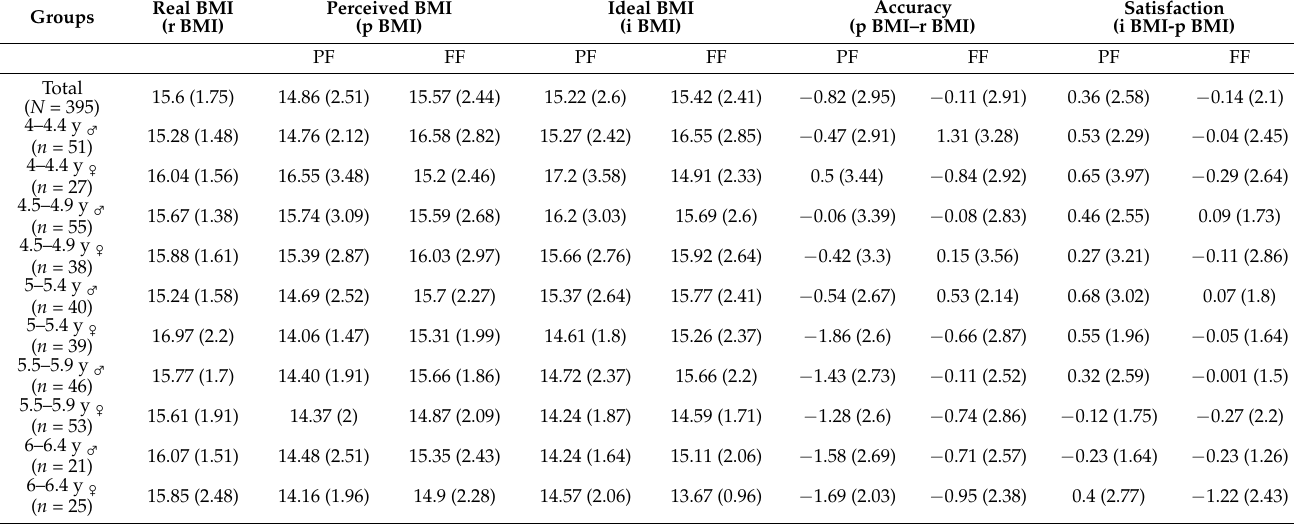
Table 2. Mean (SD) of real, perceived, and ideal BMI, discrepancy scores in body size perception, and body dissatisfaction according to gender and